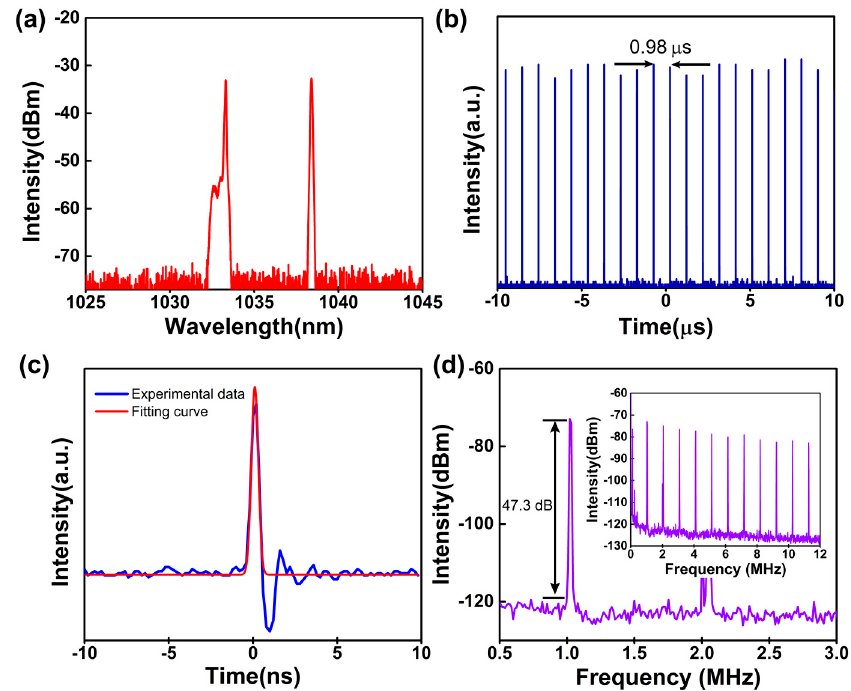
Figure 5. The properties of output mode-locked pulse: ( a ) Spectrum; ( b ) pulse train; ( c ) single pulse profile; and ( d ) radio frequency (RF) spectrum of the mode-locked laser; inset: RF spectrum in a large range of 12 MHz.